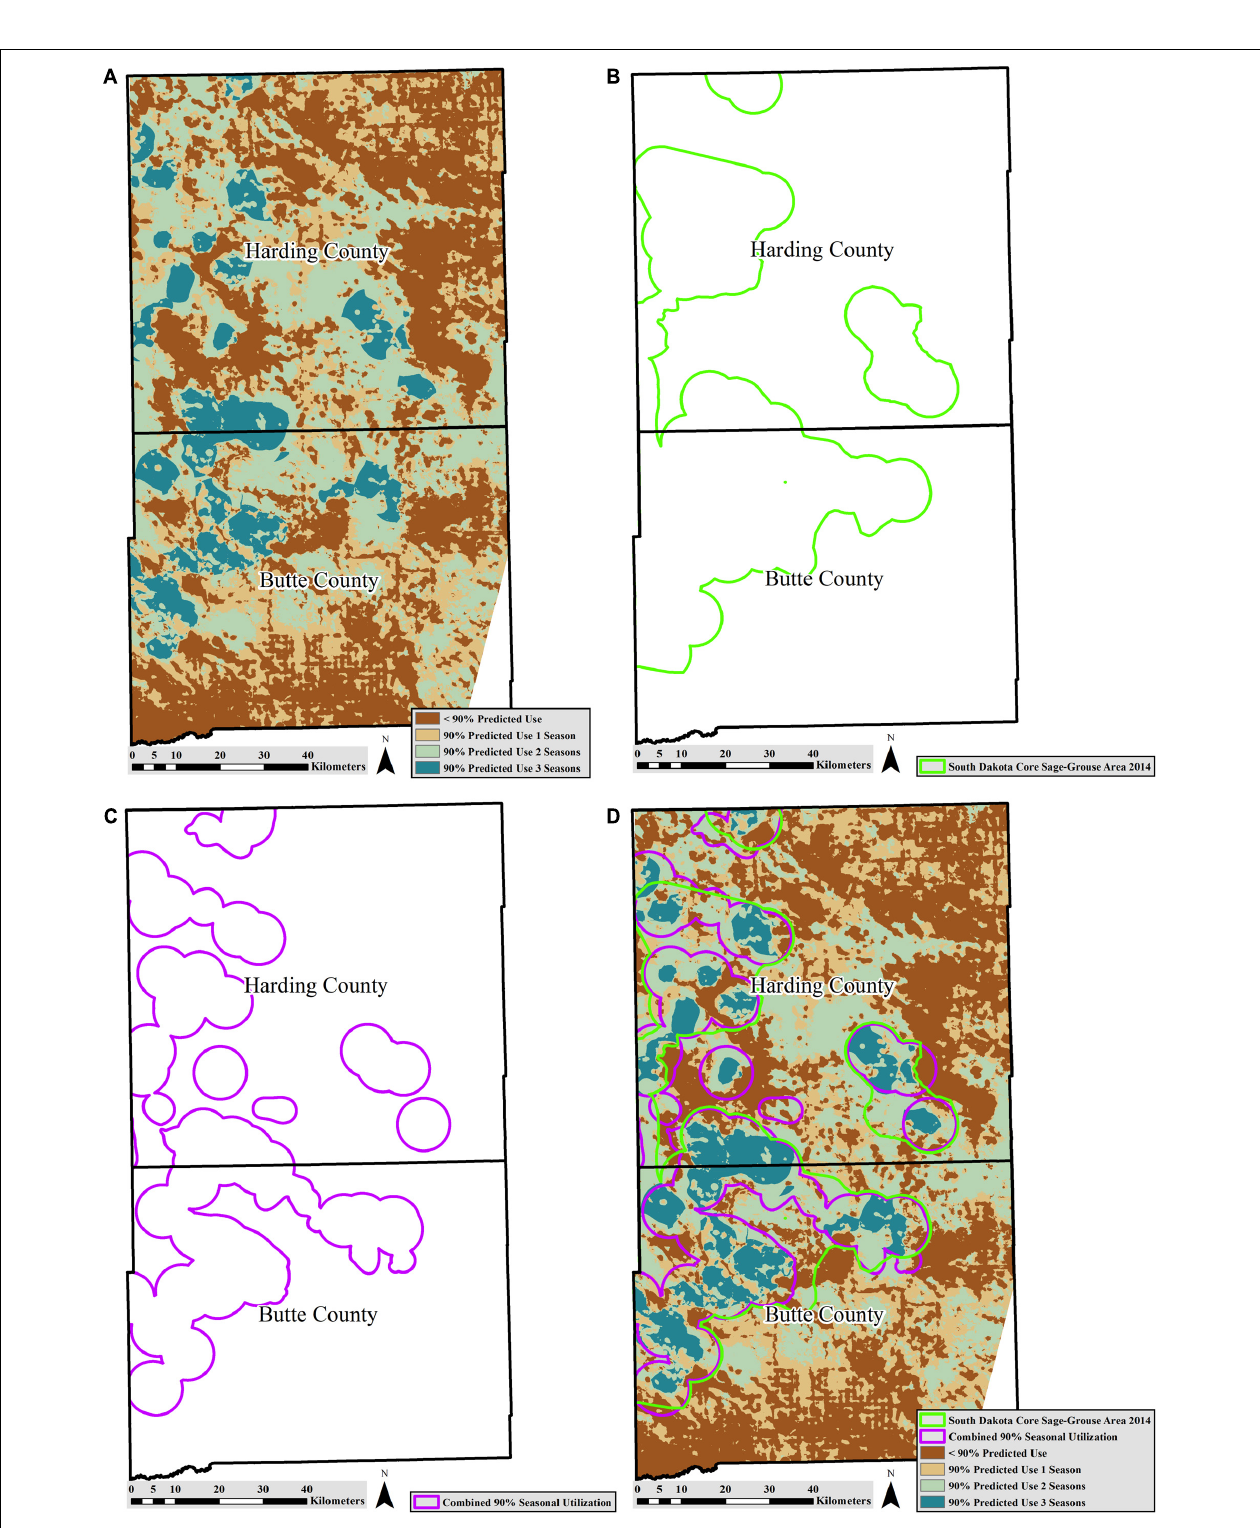
FIGURE 2 | Study area in Butte and Harding counties, South Dakota with: (A) predicted multi-season use generated from resource selection function (RSF) models, (B) 2014 South Dakota sage-grouse priority area generated using 6.4 km lek buffers, high use areas, and connectivity corridors, (C) combined 90% isopleths from spring/summer utilization distribution, winter utilization distribution, and a 6 km lek buffer, and (D) all three methods of defining a priority area overlaid on one another for comparison.